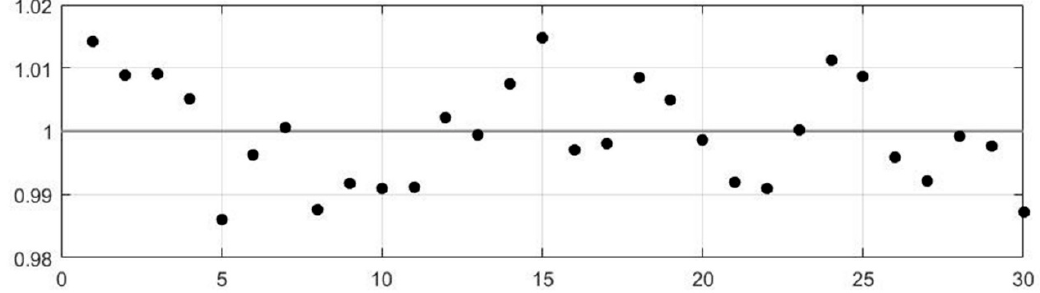
Figure 9. Variance plot of normalized FFT results over 30 datasets.